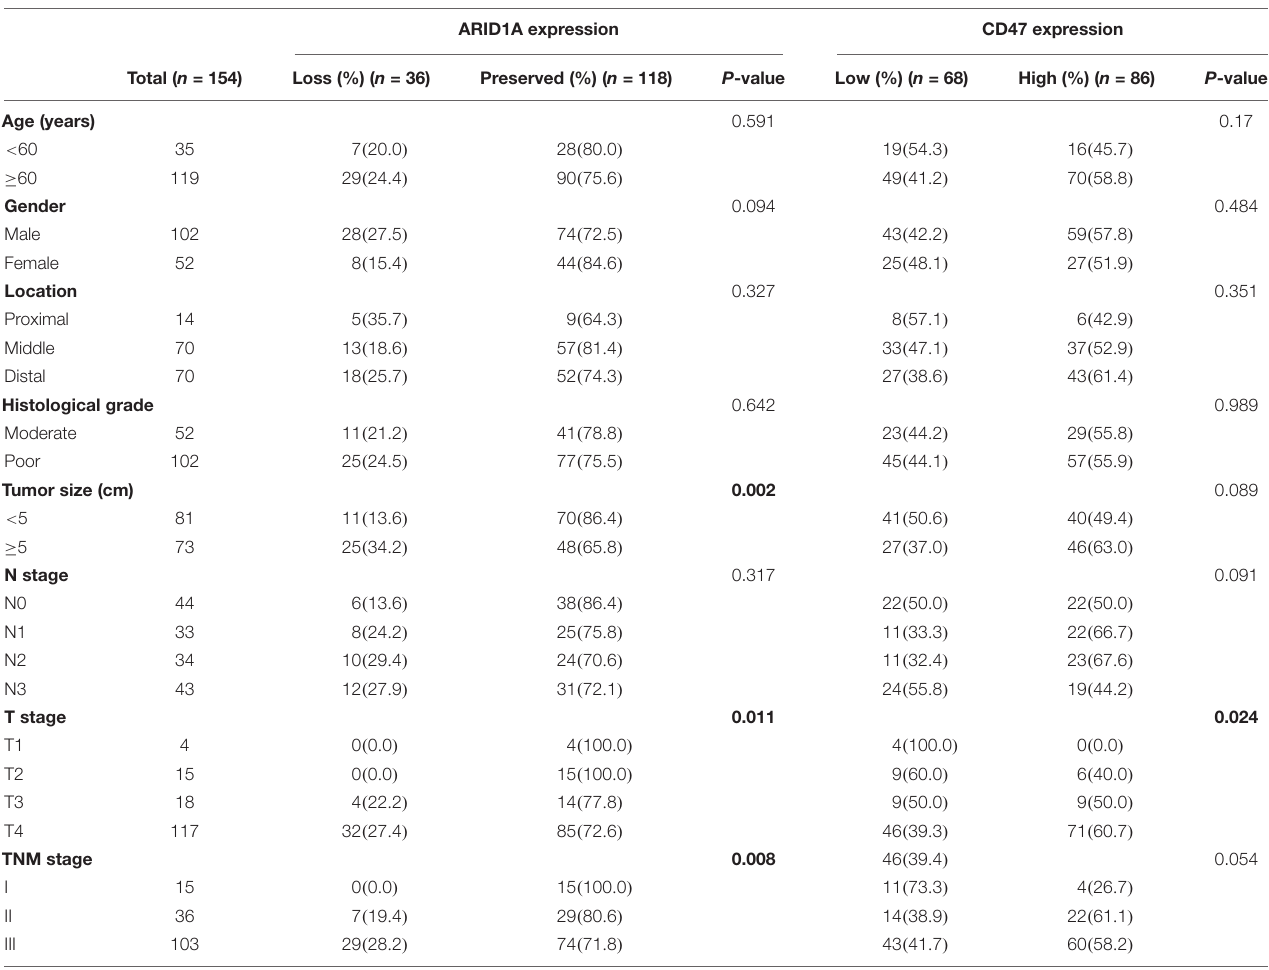
TABLE 2 | The correlation between ARID1A status and CD47 expression and clinicopathological characteristics. ARID1A